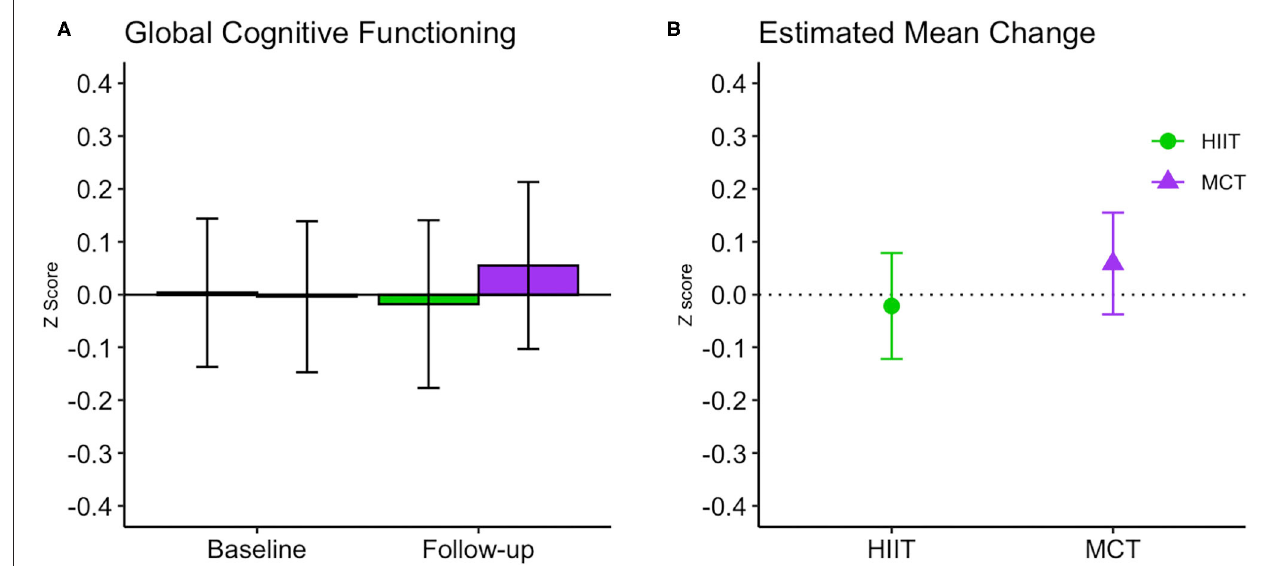
FIGURE 4 | Baseline and follow-up means for global cognitive function ( A , group mean and 95% CI) and estimated mean change from baseline to 6 months ( B , estimated mean change and 95% CI). CI, confidence interval; HIIT, high-intensity interval training; MCT, moderate-intensity continuous